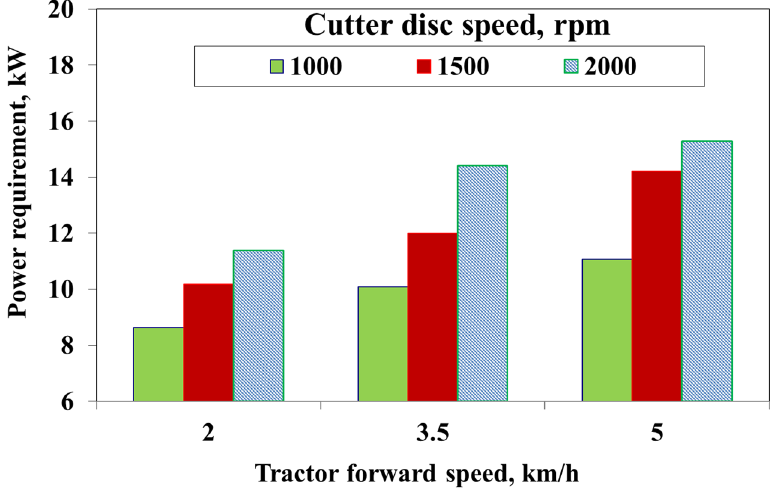
Figure 5. The power requirement as affected by tractor forward speed and cutting disc speed.